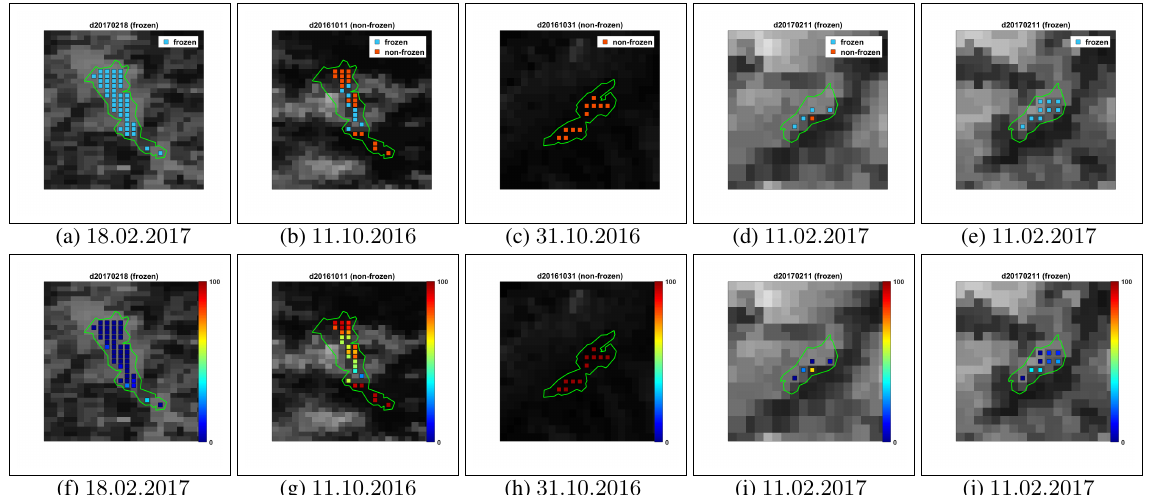
Figure 7: Results from winter 2016 - 17 on VIIRS data. First and second rows show classification and regression results, respectively. In regression, red means non-frozen and blue frozen. results for cloudy clean pixels are not displayed. Best viewed on screen.